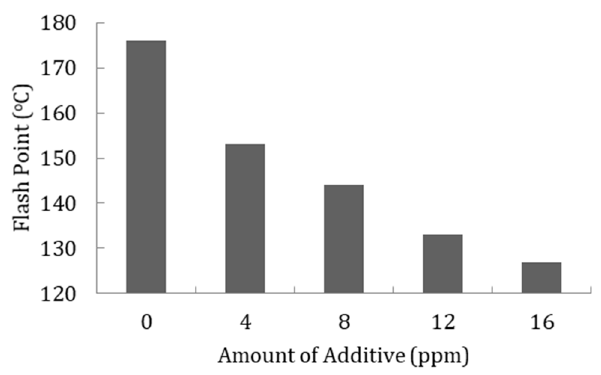
Figure 4. Effect of organic-based Mn additive on flash point.